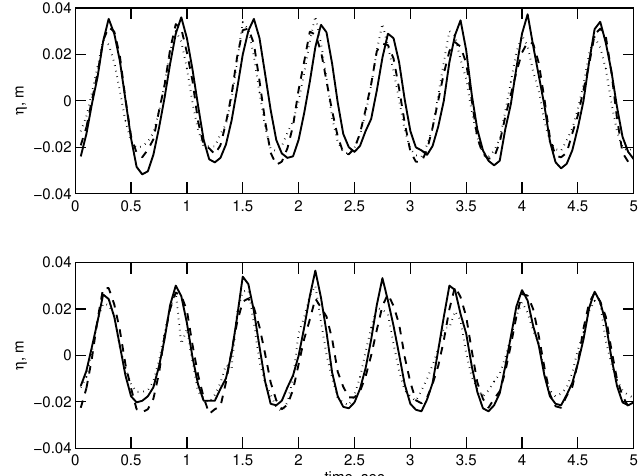
Figure 1. Time series of surface elevations η measured at the first wave probe. (top panel) Waves of U / c = 0 and f 0 = 1.6 Hz for different ε 0 : 0.31 (solid line), 0.25 (dashed line), 0.23 (dotted line). (bottom panel) Waves of ε 0 = 0.23 and f 0 = 1.6 Hz under different wind forcing: U / c = 0 (solid line), U / c = 1.4 (dashed line), U / c = 11 (dotted line). The waves propagate from right to left. Reproduced from [10].